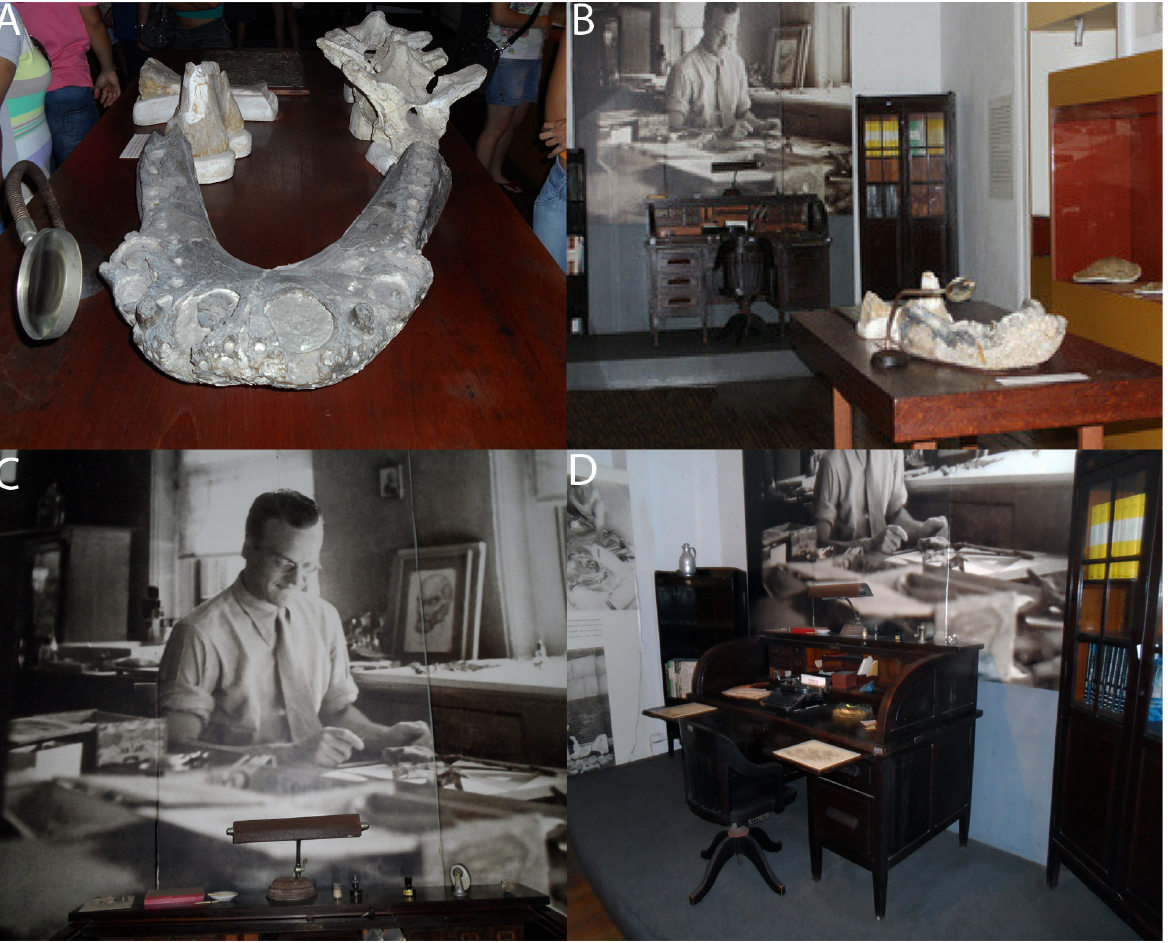
Figure 2: Photographs of the exhibition “Llewellyn Ivor Price + 100, um Paleontólogo”, curated by Diogenes de Almeida Campos. a) the anterior portion of DGM 527-R was exposed on the central table; b) wide view of the room with the central table including DGM 527-R; c) picture of L. I. Price used as the background of the exhibition; and, d) reconstitution of the original L. I. Price working